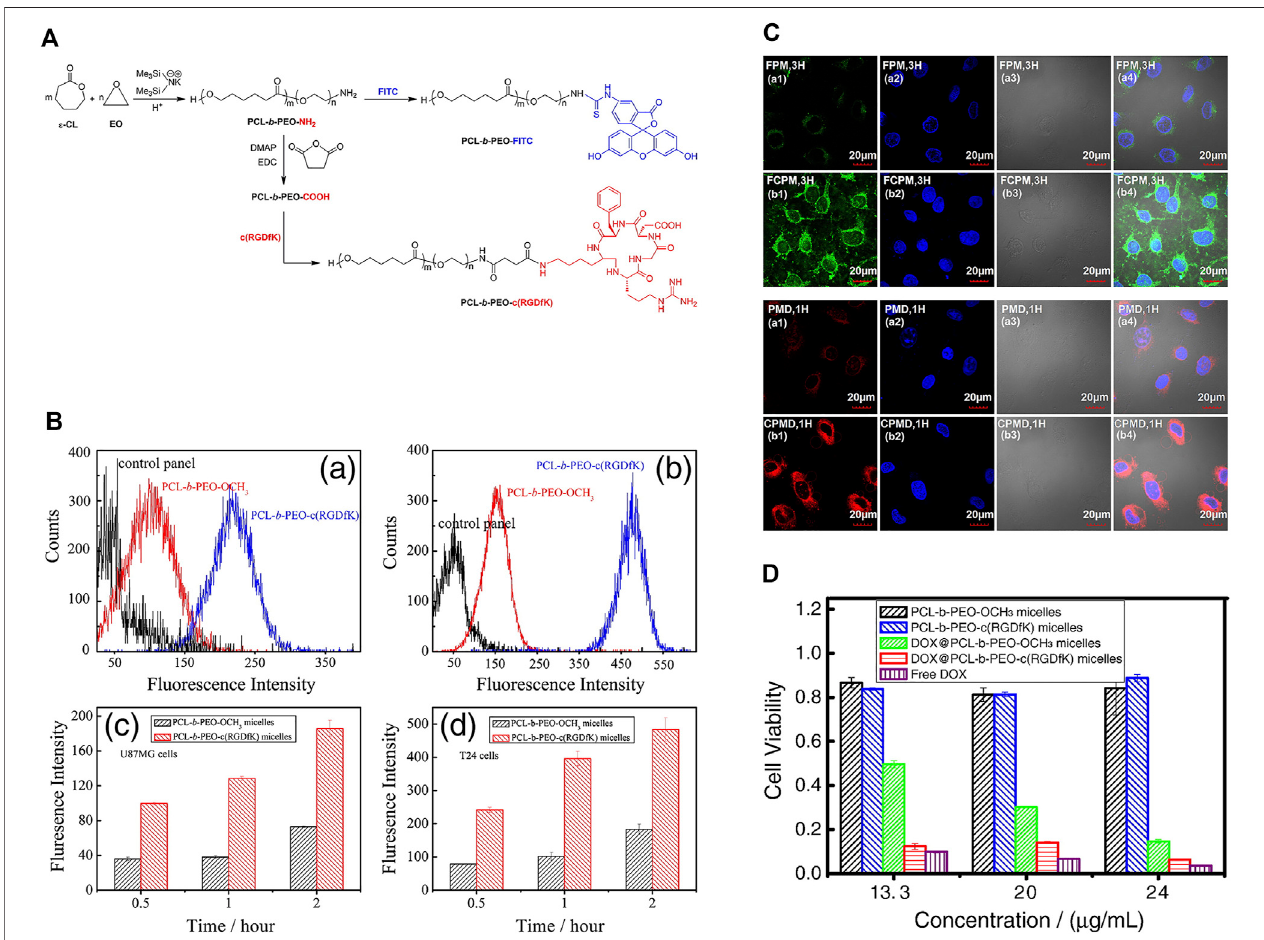
FIGURE 8 | c (RGDfK) and FITC-modi fi ed PCL-b-PEO-NH 2 for intravesical instillation therapy of bladder cancer (A) Synthetic routes of conjugation of c (RGDfK) and FITCtoPCL-b-PEO-NH 2 . (B) Cellular uptake ofU87MG (a, c) and T-24 cellstreatedwith different nanogelsfor 2 h. (C) Confocal laserscanningmicroscopyimages of T24 bladder cancer cells treated with FITC-labeled and Dox-loaded nanomicelles. (D) Viability of T24 bladder cancer cells treated with different